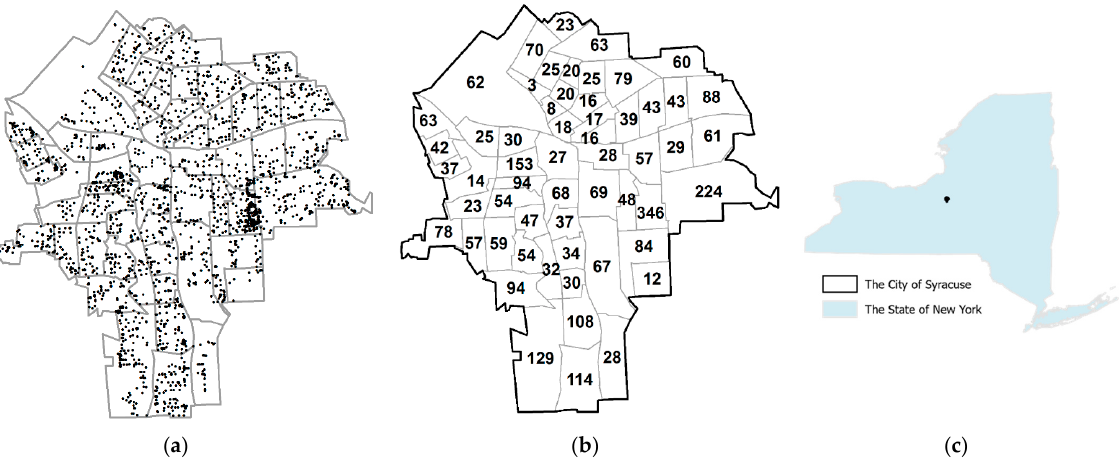
Figure 1. Syracuse, NY. ( a ) The geographic distribution of trace metal soil samples overlaid with a polygon map of the 2000 United States census tract boundaries. ( b ) The distribution of number of soil samples with analytical assay error measurements. ( c ) The study area in the state of New York.